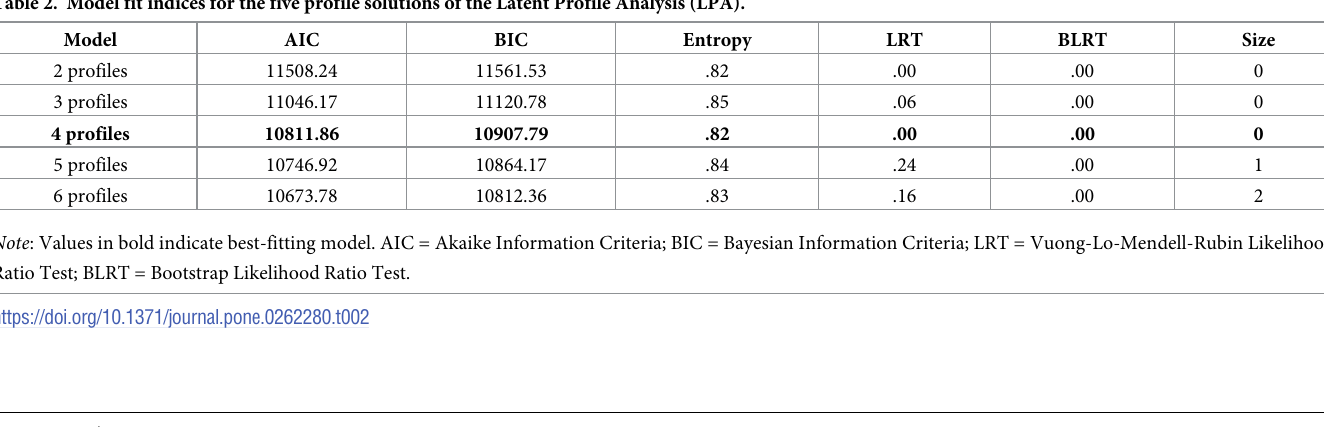
Table 2. Model fit indices for the five profile solutions of the Latent Profile Analysis (LPA). Model